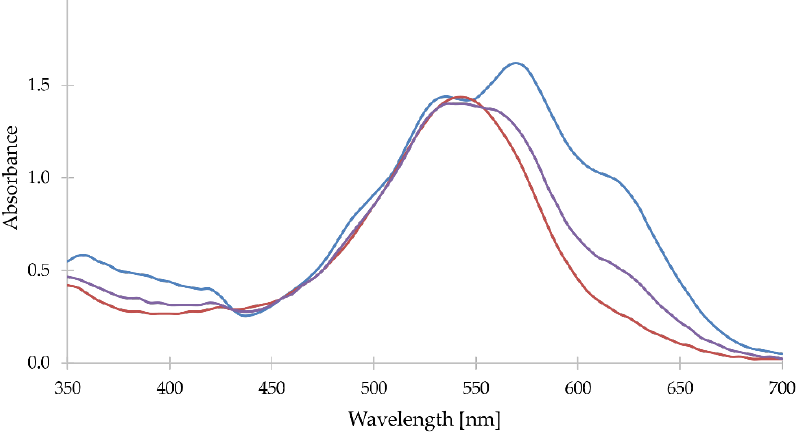
Figure 3. Visible absorption spectra of samples F 1 (red), F 2 (purple) and F 3 (blue) of Sphagnorubin C ( 1 ). The samples, which have different pre-treatment (see Section 4.2), were dissolved in pure DMSO/ d -DMSO. The spectra show that different amounts of the flavylium cationic form were transformed into quinoidal forms depending on the pre-treatment of each of the samples. The spectra are normalised to the isosbestic point at 455 nm.